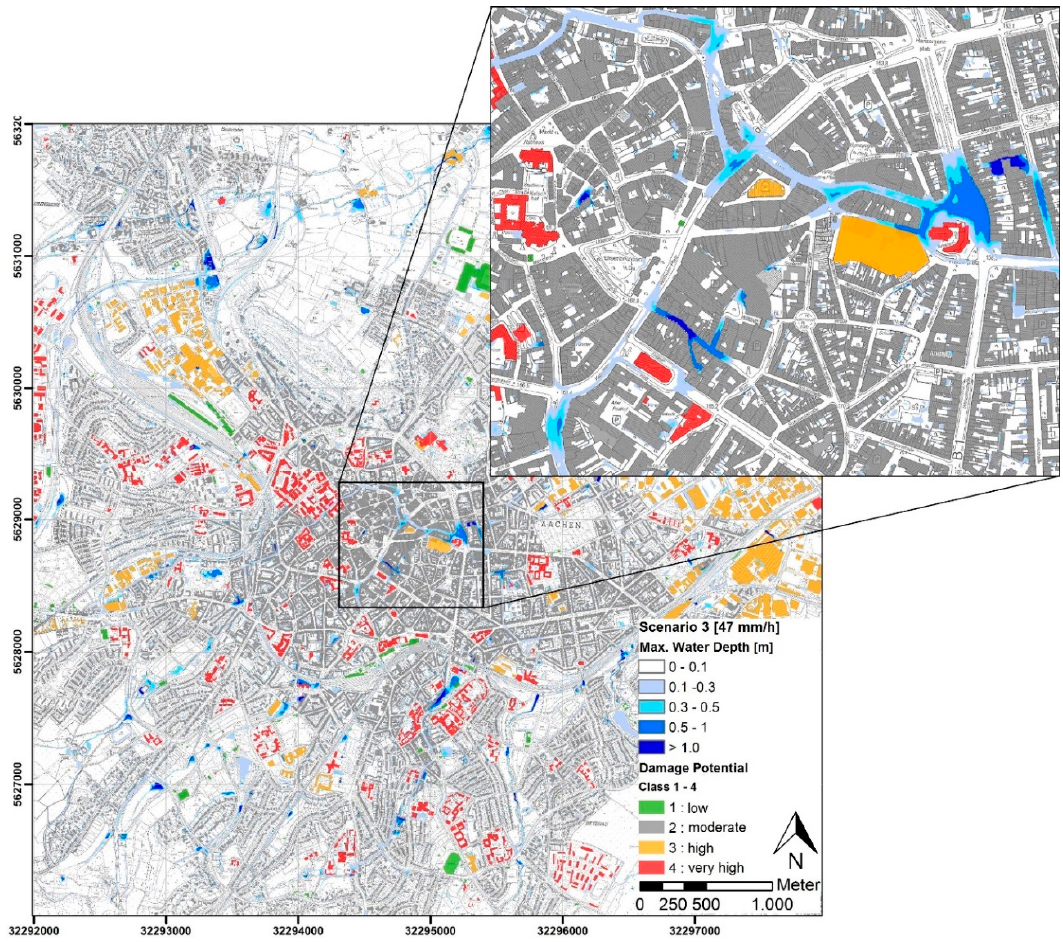
Figure 4. Combined mapping of flood hazard and damage potential for scenario three ( T N = 100a) with enlarged view of central areas in Aachen (Kaiserplatz) [35].